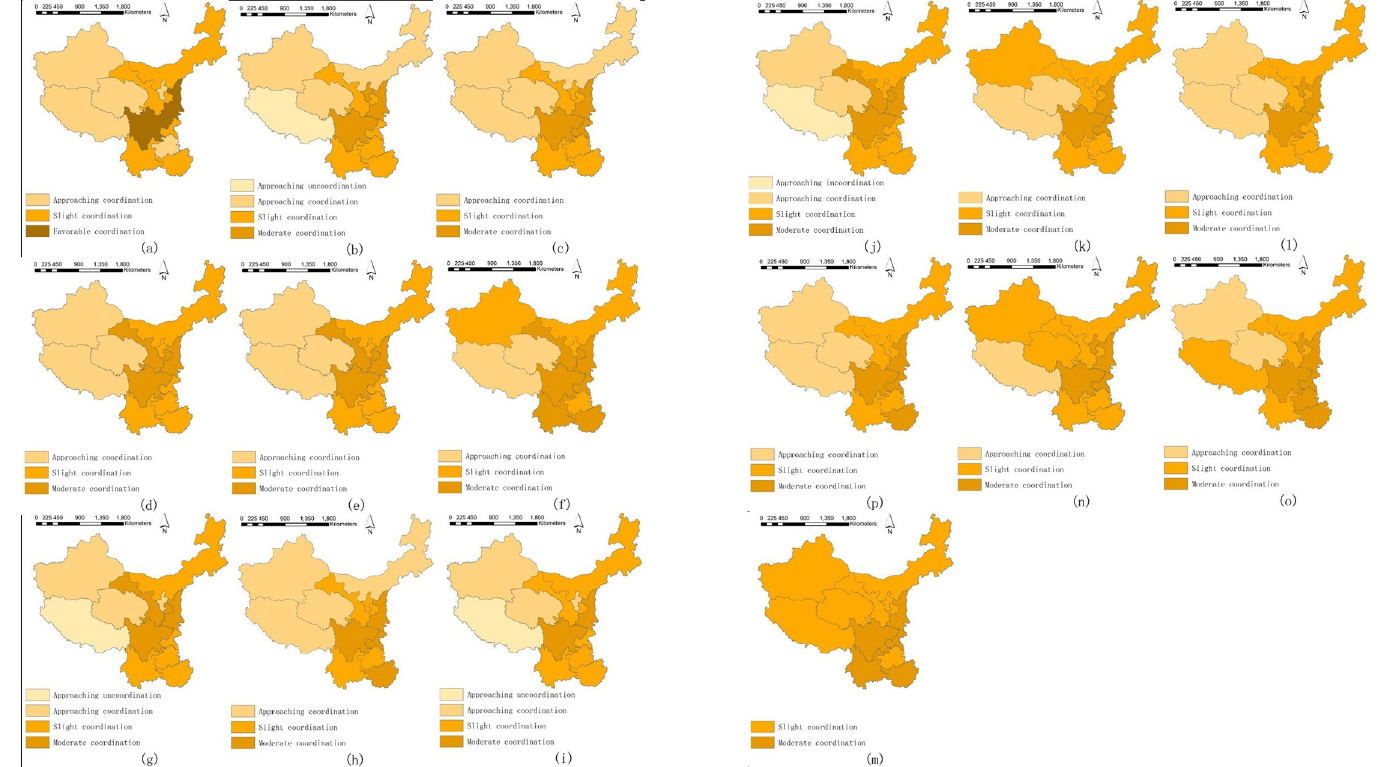
Fig 7. a. Spatial variations of COU. (a-i) 2004–2012. b. Spatial variations of COU. (j-p) 2013–2019.